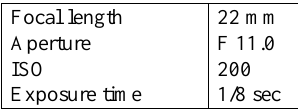
Table 1. Camera parameters during the image acquisition